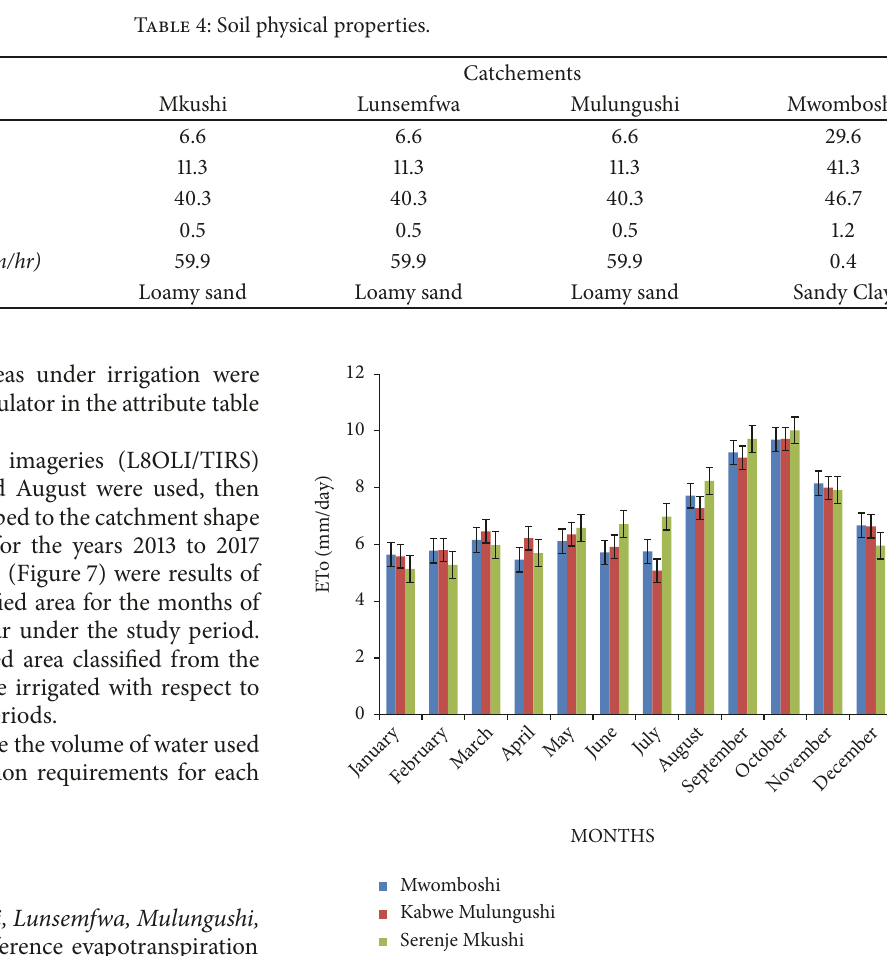
Figure 2: Five-year average monthly ETo Mkushi, Mwomboshi, Lunsemfwa, and Mulungushi